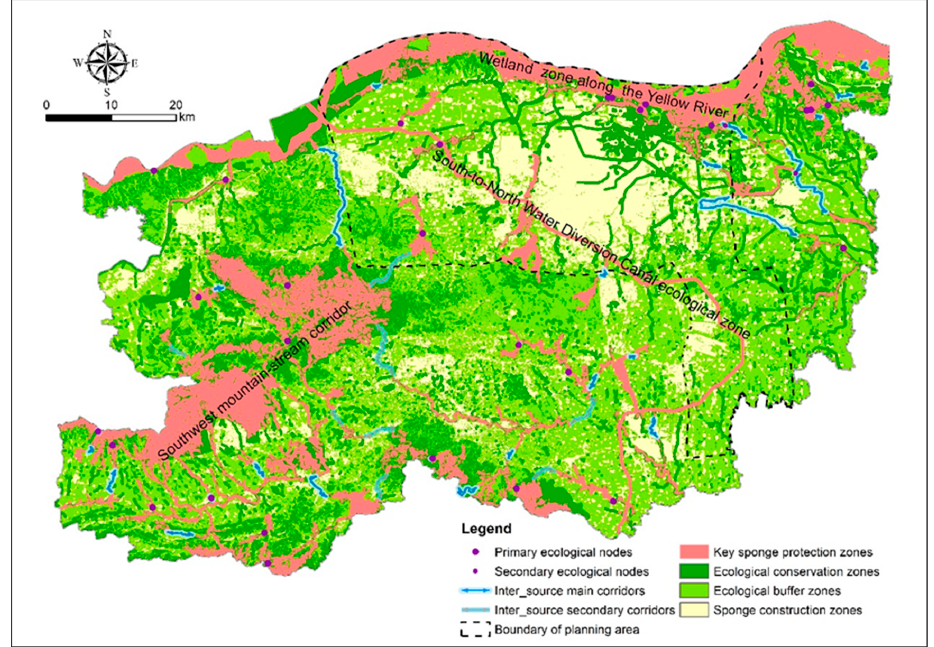
Figure 8. ESP for Zhengzhou.